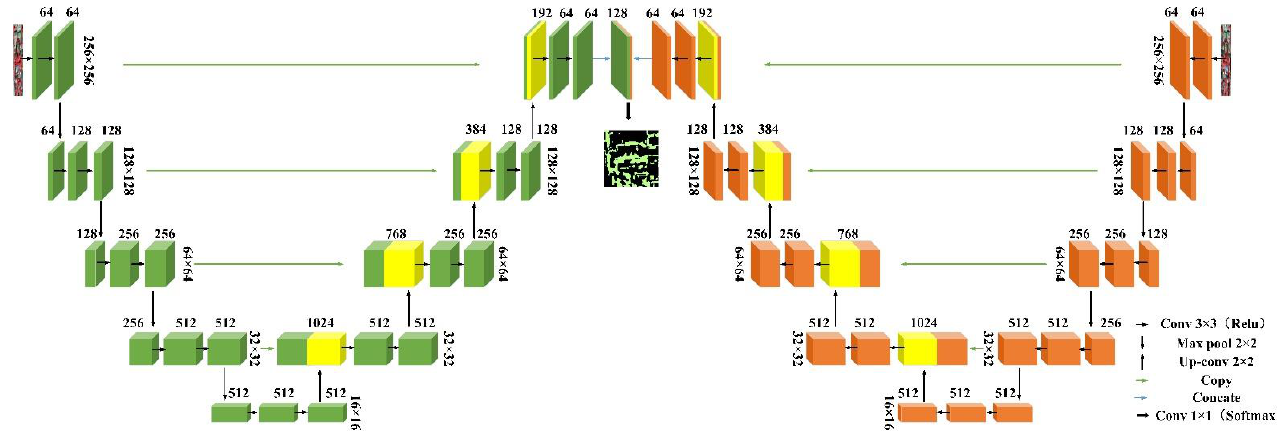
Figure 4. Architecture of DBDU (double-branch U-NET based on decision fusion strategy). Each green box represents the multi-channel feature map obtained by the first-phase satellite image operation, each orange box represents the multi-channel feature map obtained by the second-phase satellite image operation, the yellow box represents the feature map after transposed convolution. The number of channels is above the box, and the size is on the right side of the box. Different arrows represent different operations.